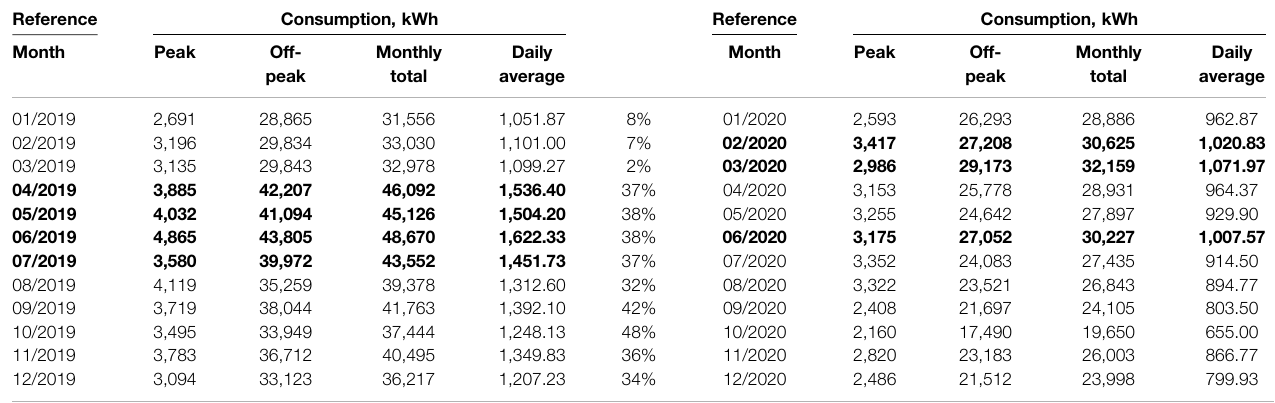
TABLE 4 | Monthly energy consumption for the base years 2019 and 2020.